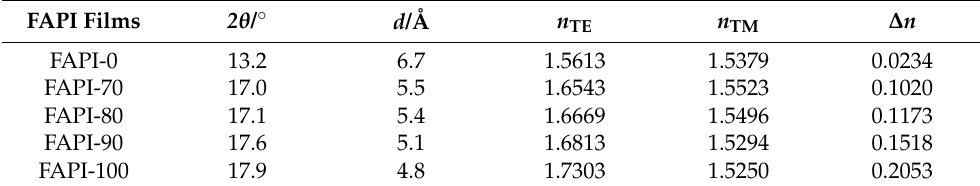
Figure 8. WXRD curves of the FAPI films with different biphenyl content in polymer backbone. Table 5. WXRD, TMA and BR data of the FAPI films.